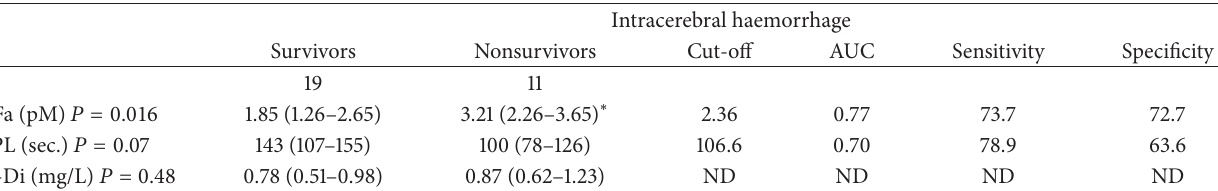
Table 2: Procoagulant phospholipids (PPLs), tissue factor activity (TFa) and D-Dimers (D-Di) in the CSF of survivor and nonsurvivor patients with